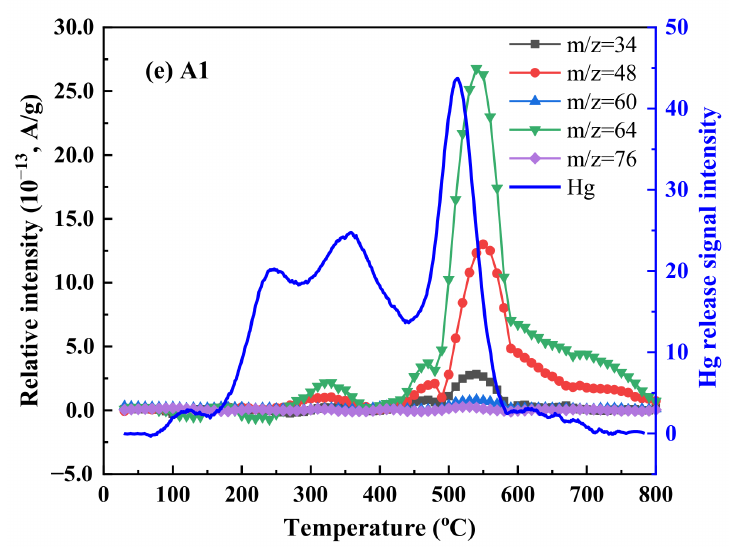
Figure 10. Evolution characteristics of pyrolysis products. ( a ) P1 (peat); ( b ) L3 (lignite); ( c ) SB2 (sub-bituminous coal); ( d ) B1 (bituminous coal); ( e ) A1